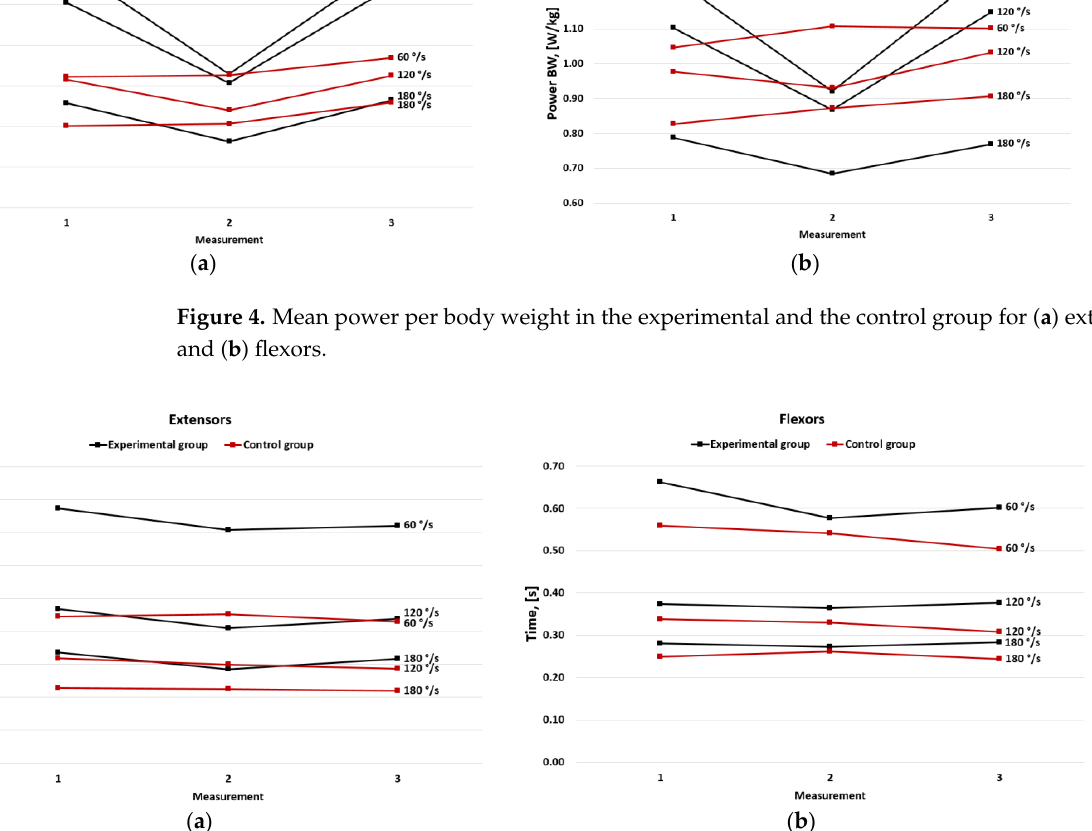
Figure 5. Mean of time to peak torque in the experimental and the control group for ( a ) extensors and ( b ) flexors. and ( b )